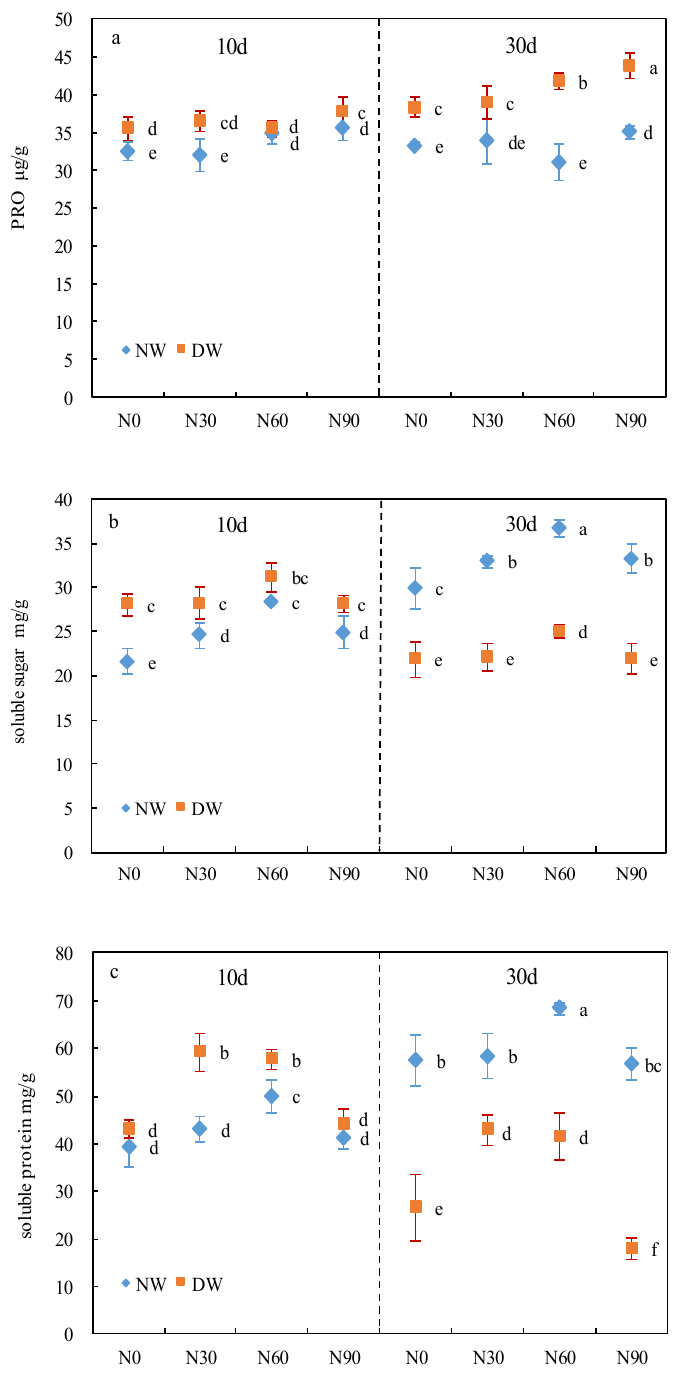
Figure 3. ( a ) Effect of drought stress and nitrogen deposition on PRO content; ( b ) effect of drought stress and nitrogen deposition on soluble sugar content; ( c ) effect of drought stress and nitrogen deposition on soluble protein content. Water supply treatments: normal water supply (NW) or drought stress (DW) for 10 d or 30 d. Nitrogen deposition treatments: control (N0, 0 kg·hm − 2 year − 1 ), low nitrogen deposition (N30, 30 kg·hm − 2 year − 1 ), medium nitrogen deposition (N60, 60 kg·hm − 2 year − 1 ), or high nitrogen deposition (N90, 90 kg·hm − 2 year − 1 ). Abbreviations: PRO, proline. Data points represent means ± the SD; n = 5. Data points with the same lowercase letter are significantly different ( p < 0.05) according to Tukey’s test.